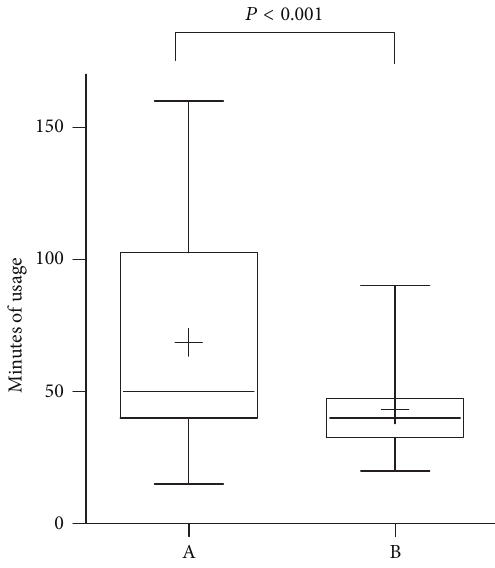
Figure 4: Self-evaluation of time spent with the online tutorial. A: 𝑛 = 14 ; medical students after learning success study using survey monkey. B: 𝑛 = 13 ; postgraduate medical doctors as part of the VAS questionnaires using paper-based questionnaires.